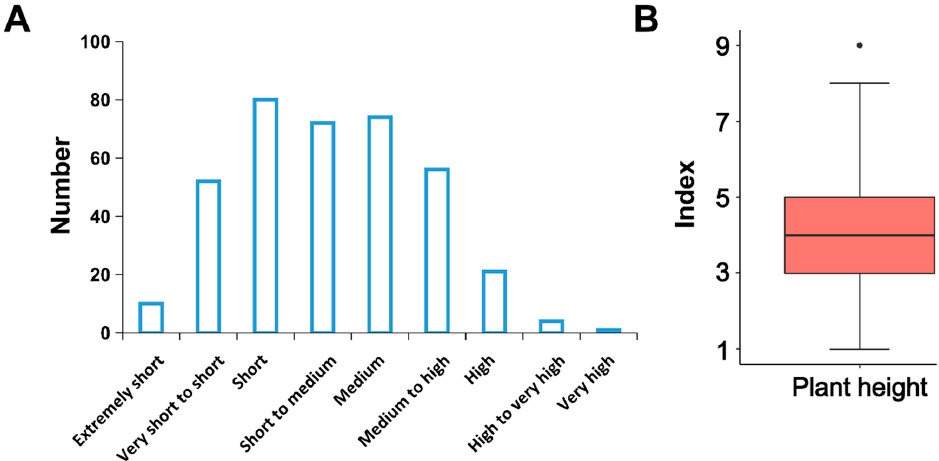
Figure 1. Distribution of the height and boxplot of the potato plant height. ( A ) Plant height distri- bution of 370 potato cultivars; ( B ) Boxplot of plant height index .